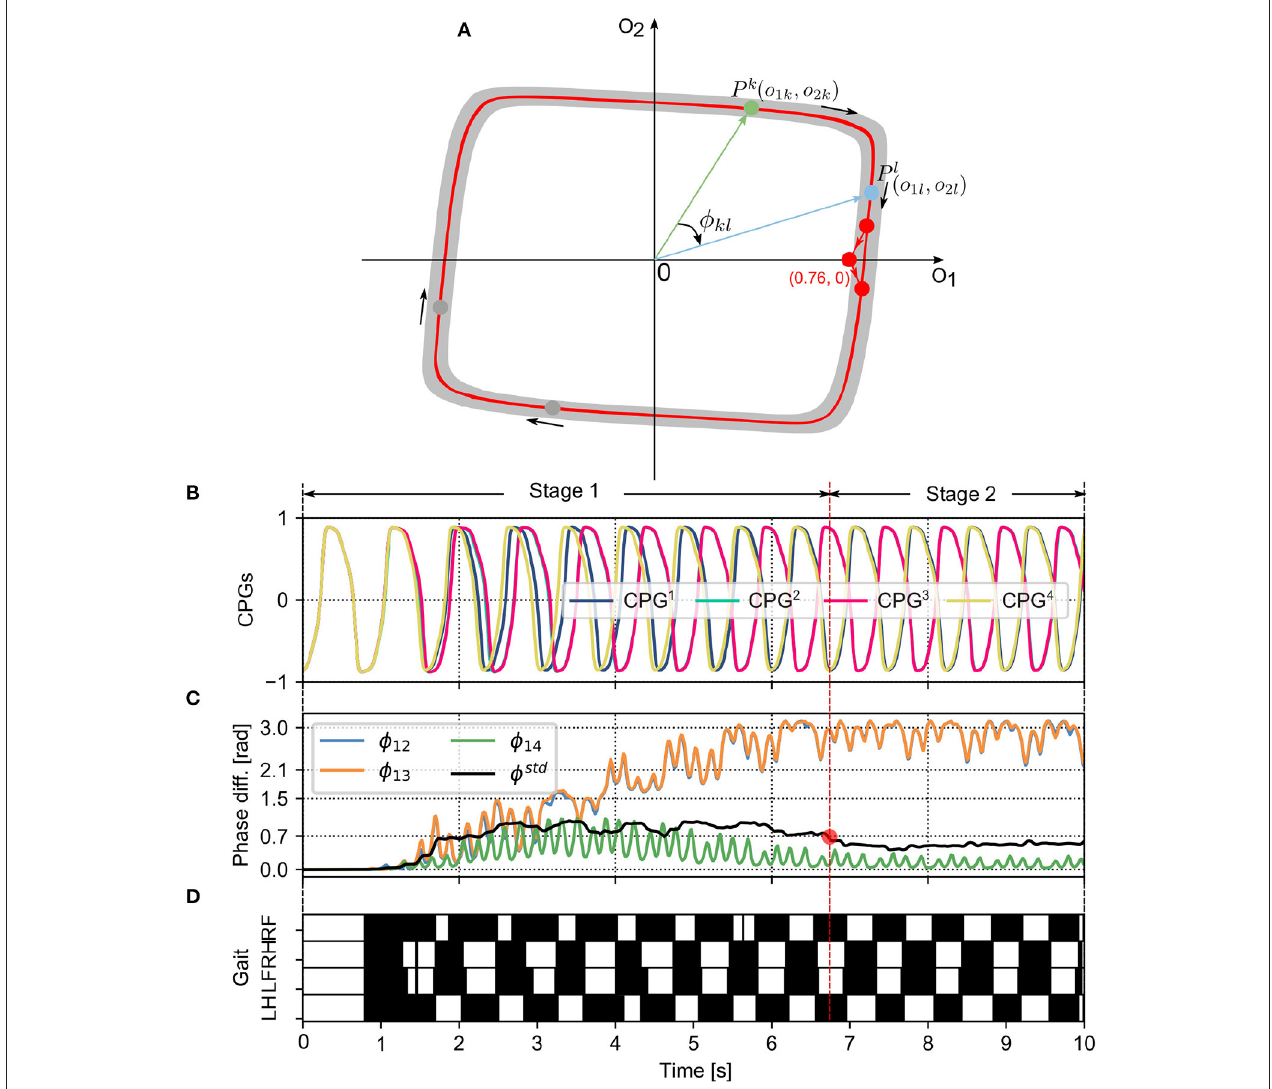
FIGURE 3 | (A) The limit cycle of the SO(2)-based CPGs that was used to investigate the autonomous phase regulation. The coordinates (0.76, 0) represent the phase-reset point realized by the PR. A phase difference (e.g., φ kl ) between two CPGs (i.e., the k th and l th CPGs) is defined as the angle between the two points (i.e., P k and P l ). (B) The first neuron outputs ( o 1 k with k=1, 2, 3, and 4) of the four CPGs that are used to control the four legs, respectively (see Figure 1 ). (C) The CPG phase differences (i.e., φ 12 , φ 13 , φ 14 ) and their standard deviation ( φ std ). φ std can indirectly reflect the phase deviation. Empirically, once the value of φ std reduces to < 0.7 (see the red point), the CPG outputs and phase differences become more stable. The CPG phase convergence process can be divided into two stages (Stage 1 and Stage 2) determined by the point. (D) In the corresponding gait diagram, the black areas indicate stance phases while the white areas indicate swing phases. Note that, φ 12 , φ 13 , and φ 14 are the phase differences of the CPG 2 , CPG 3 , and CPG 4 with respect to the CPG 1 , respectively. RF, RH, LF, and LH are the right front, right hind, left front, and left hind legs, respectively.